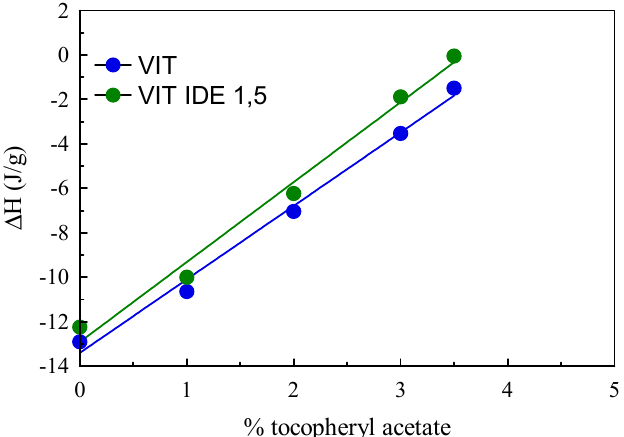
Figure 9. Enthalpy variation ( ∆ H) of NLC (unloaded NLC = VIT; 1.5% w / w , IDE-loaded NLC = VIT IDE1,5), as a function of the percentage of tocopheryl acetate. Table 3. Enthalpy changes ( ∆ H) and recrystallization index (RI%) of unloaded SLN and NLC, IDE-loaded SLN, and 5% w / w IDE-loaded